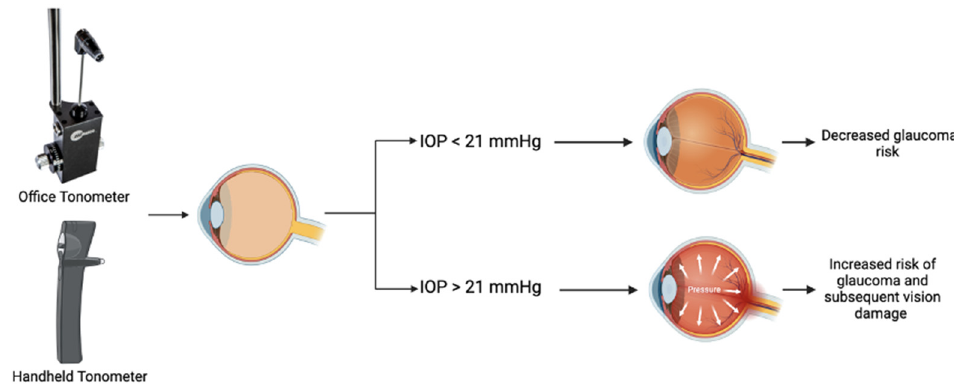
Figure 1. IOP threshold used for assessing risk in participants .